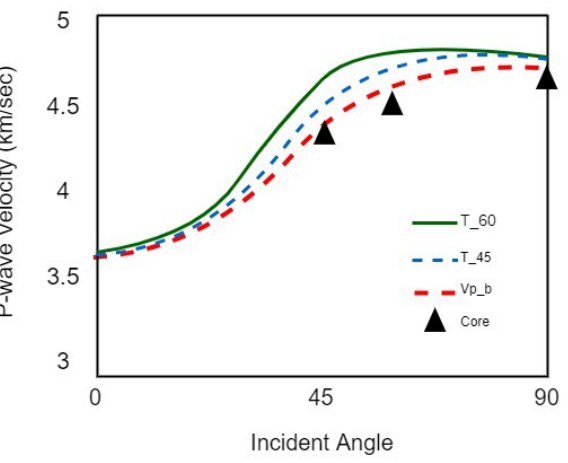
Figure 9. The partially inverted Z S sections at the near, mid, and far incident angles (from ( a – c ), respectively) against the facies log at well × 1 ( d ).